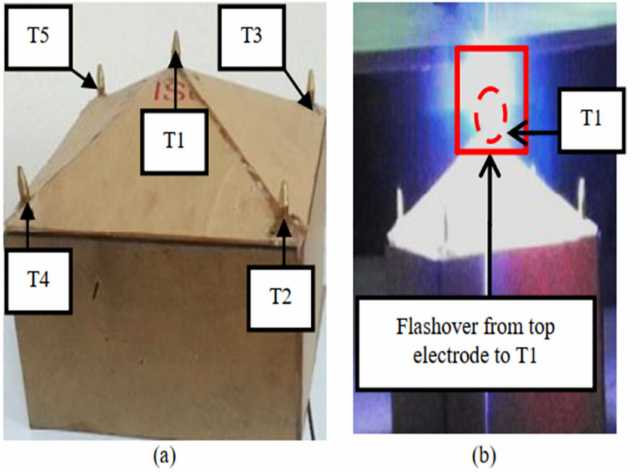
Figure 16. Lightning strike distribution on a pyramid-shape model: ( a ) scaled pyramid shape, ( b ) flashover on